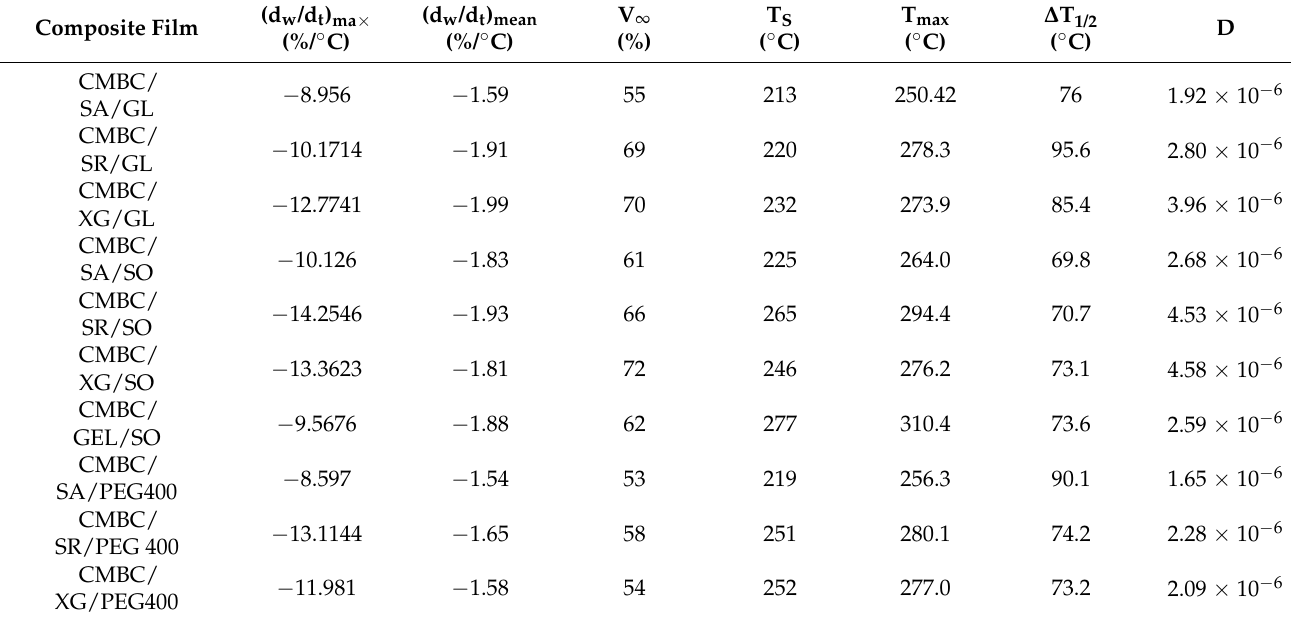
Table 7. Pyrolytic properties of the composite